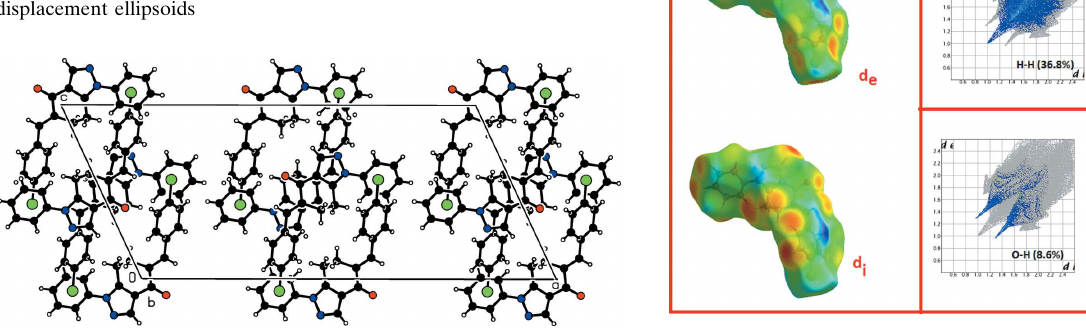
Figure 4 Hirshfeld three-dimensional surfaces (showing d norm , d i and d e ) and selected two-dimensional fingerprint